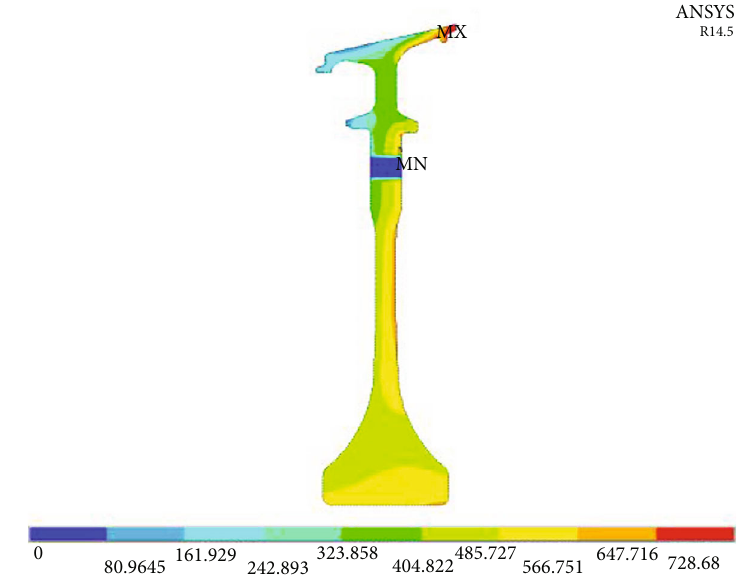
Figure 9: Circumferential stress